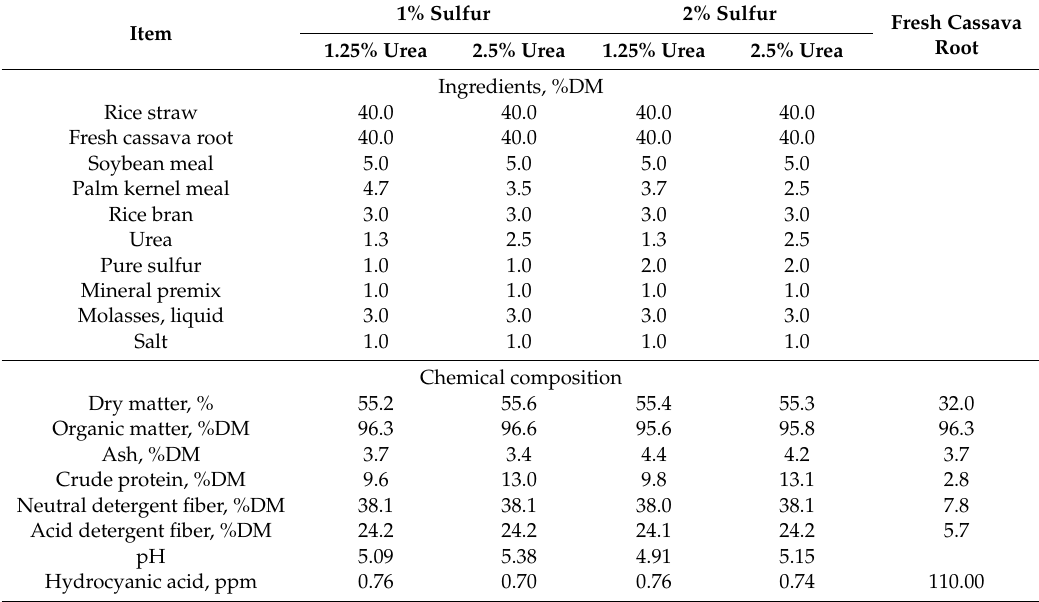
Table 1. Ingredient and chemical composition of fermented total mixed ration